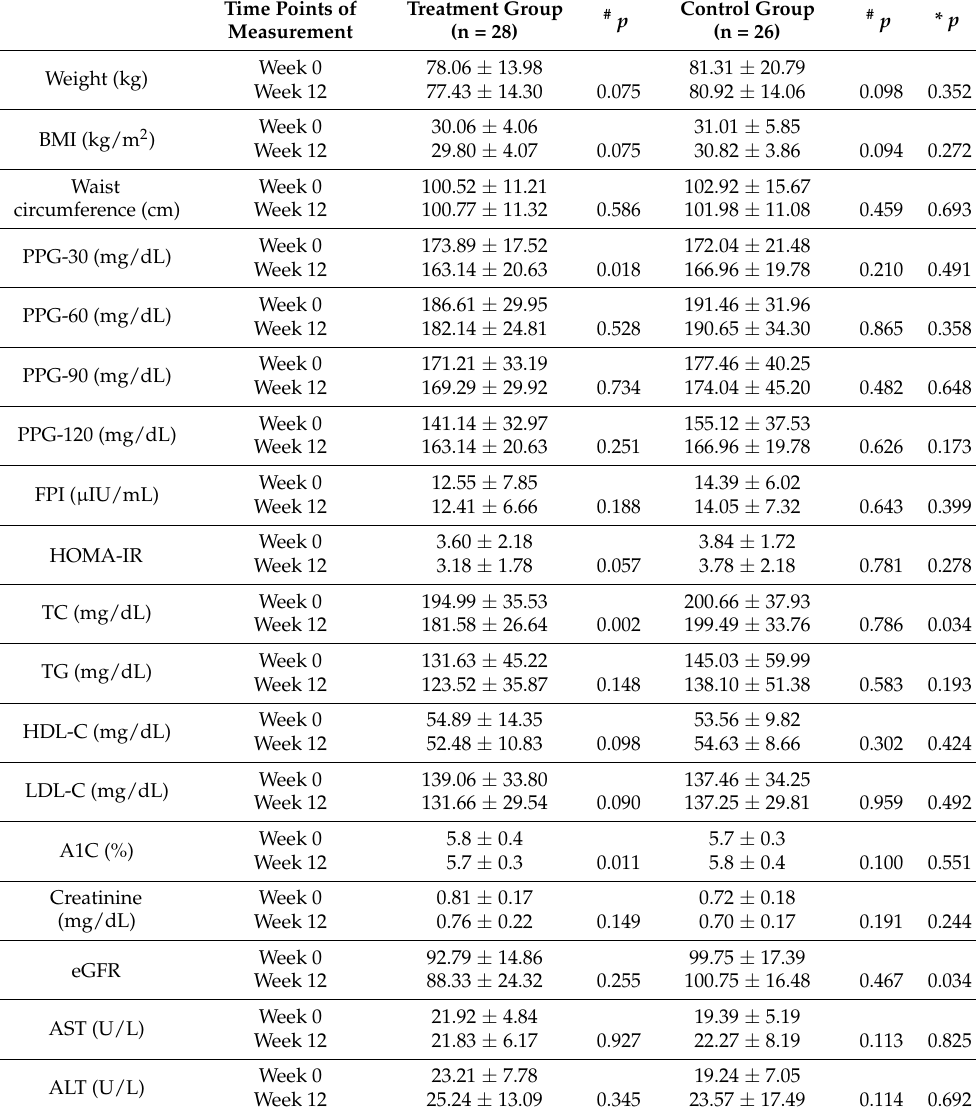
Table 2. Clinical characteristic of the